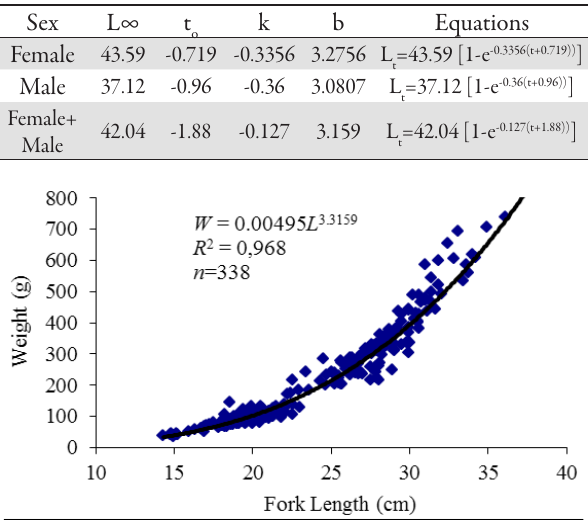
Fig. 5. Length-weight relationship of S. cephalus in Orenler